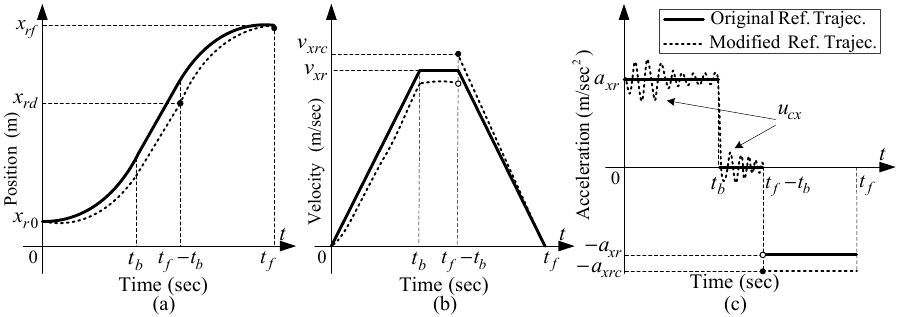
Figure 5. Comparison between original and modified reference traveling trajectory; ( a ) Position profile; ( b ) Velocity profile; ( c ) Acceleration profile.